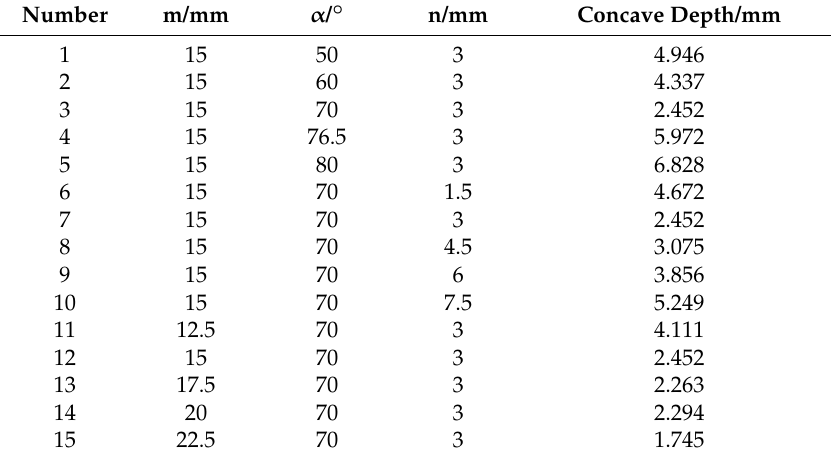
Table 1. Test design and results of single-factor test.